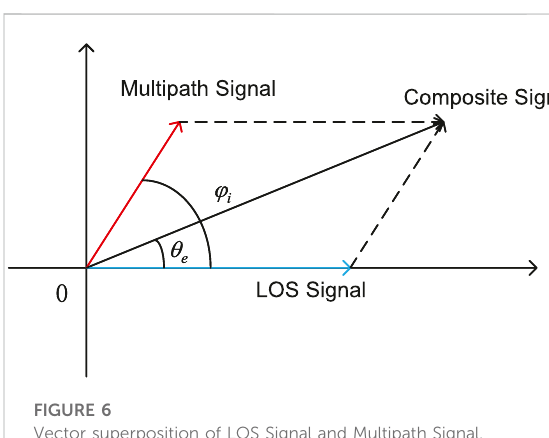
FIGURE 5 Implementation principle of PLL.